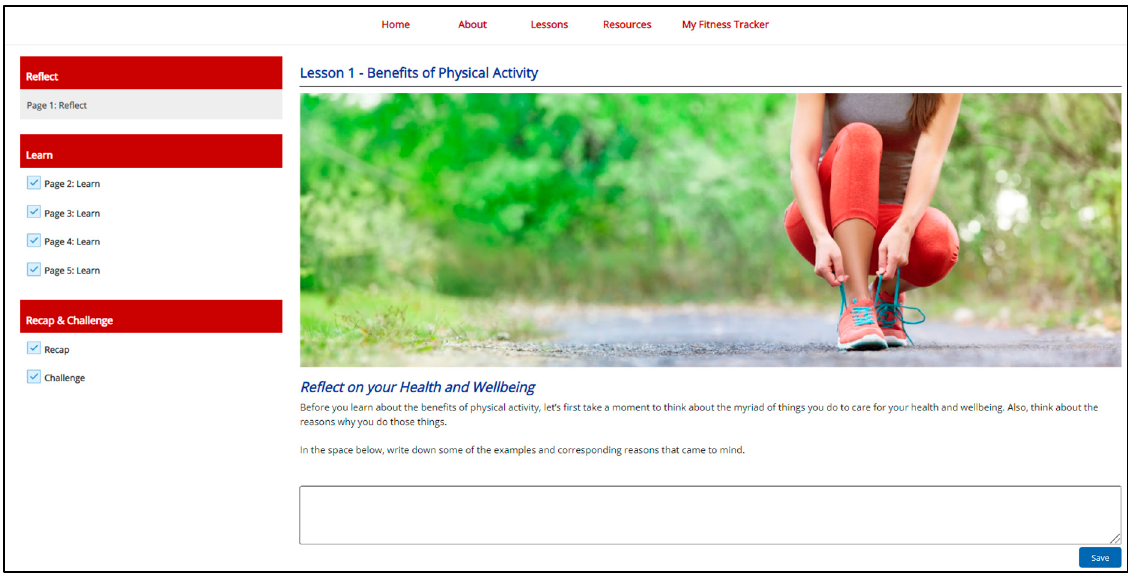
Figure 2. Sample lesson showing web